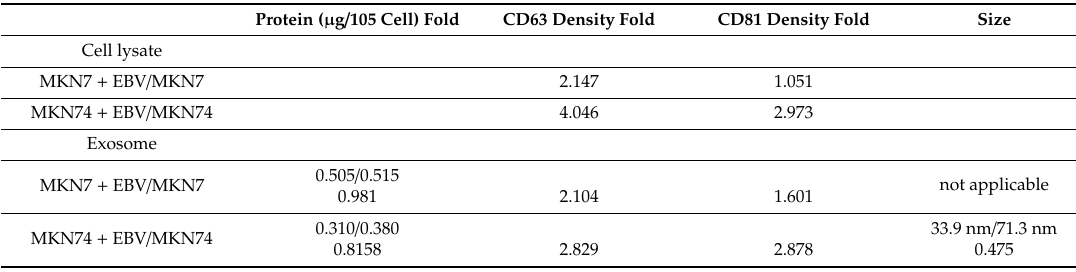
Table 1. E ff ect of artificial EBV-infection.